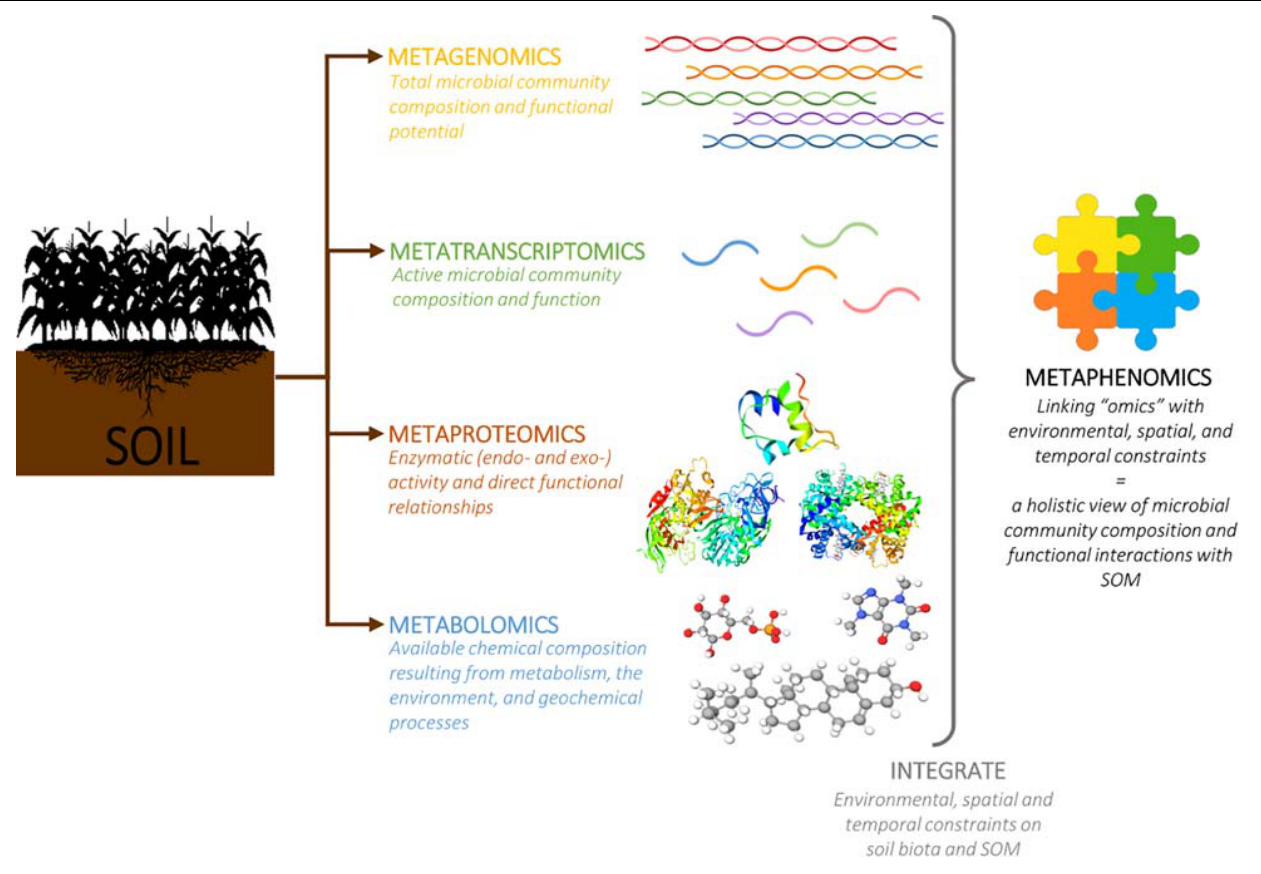
FIGURE 4 | Linking data resulting from parallel analysis of soil samples using various “omics” platforms (metagenomics, metatranscriptomics, metaproteomics, and metabolomics) provides a more holistic view (metaphenomics) of microbial community composition and understanding of functional interactions associated with biogeochemical processes involved in SOM